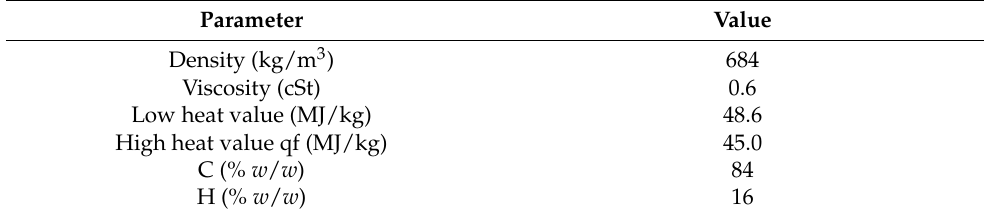
Table 1. Properties and chemical composition of n -Heptane. Parameter